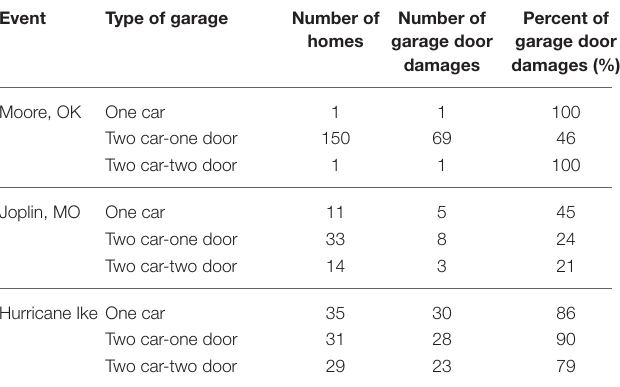
TABLE 6 | Garage door failure analysis in 90–109 mph wind speeds.